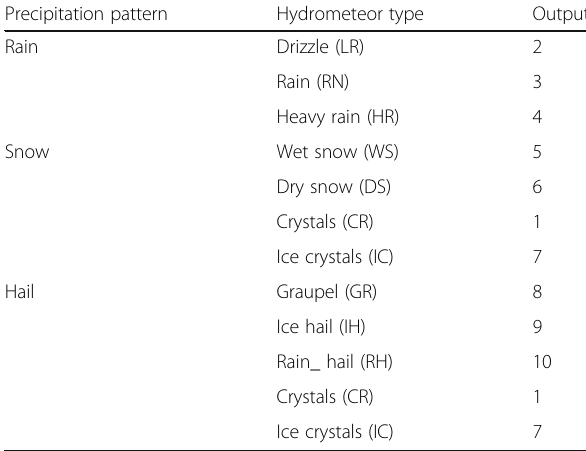
Table 2 The relationship between the precipitation pattern and the hydrometeor